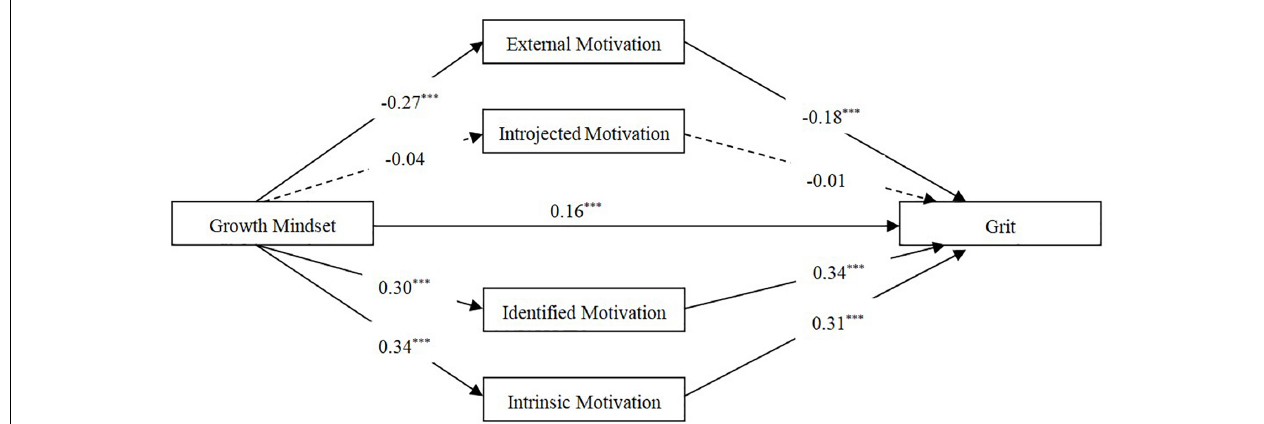
FIGURE 1 | Results of SEM (standardized estimates for paths). ∗∗∗ p < 0.001.